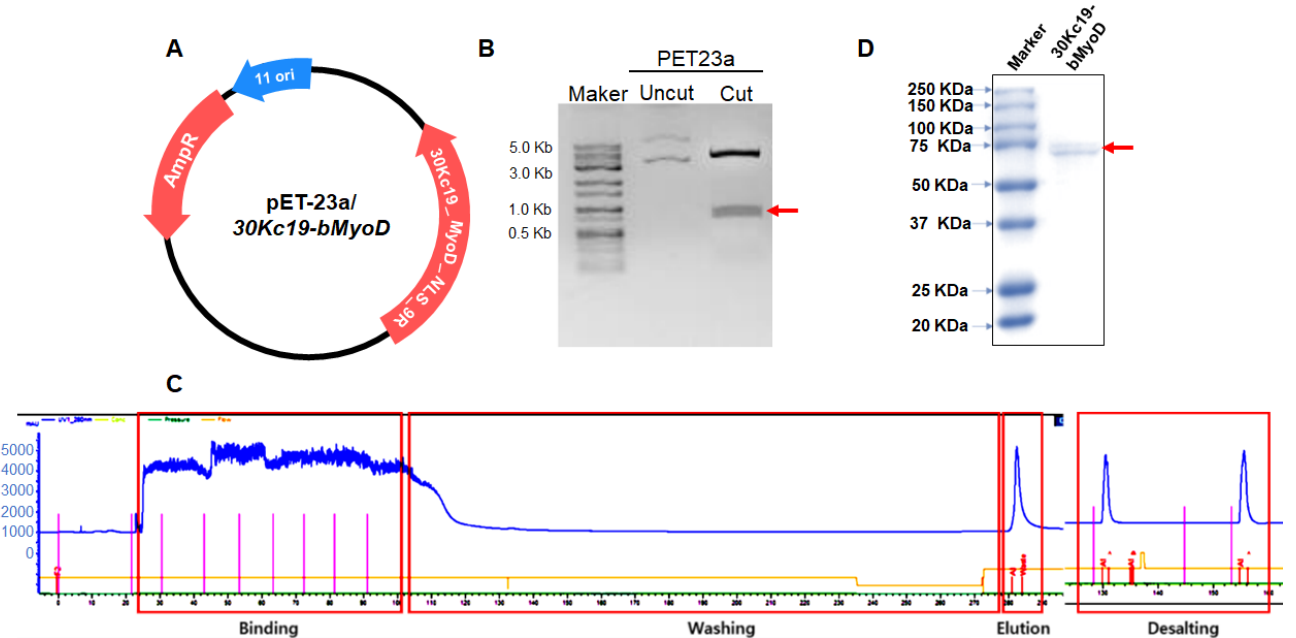
Figure 1. Gene construction and protein expression of 30MNR. ( A ) Construction of E. coli expression vector, pET − 23a/ 30Kc19 − bMyoD . ( B ) PCR gel for confirming gene cloning and double digestion of 30Kc19 − bMyoD − NLS-R9 (30MNR). A red arrow indicates 30MNR gene. ( C ) Chromatogram tracing purified 30MNR protein after elution. ( D ) SDS-PAGE gel of purified 30MNR protein. A red arrow indicates purified 30MNR protein.